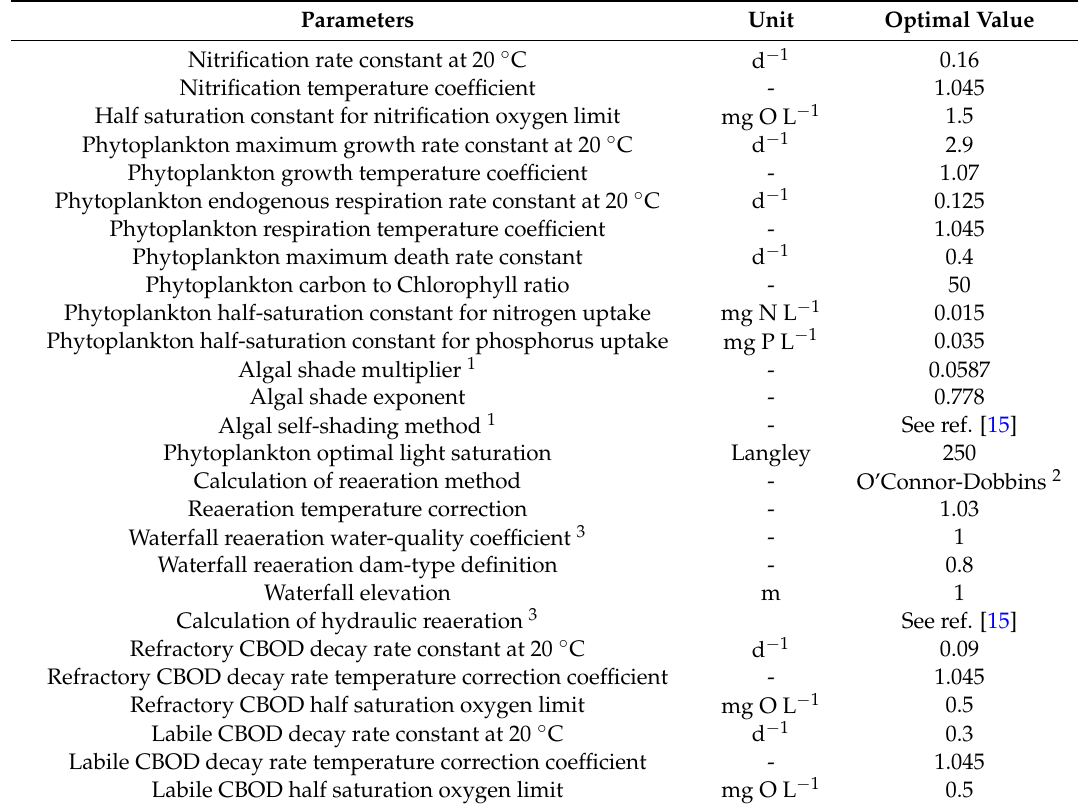
Table 2. Stoichiometric and kinetic parameters related to DO balance in the